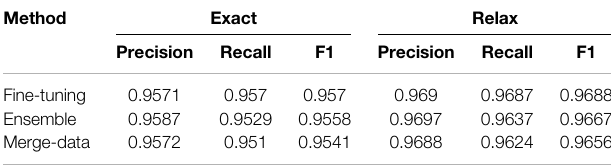
TABLE 1 | Performances of semantic role extraction for chemical reaction. Both exact and relaxed matching results are reported.